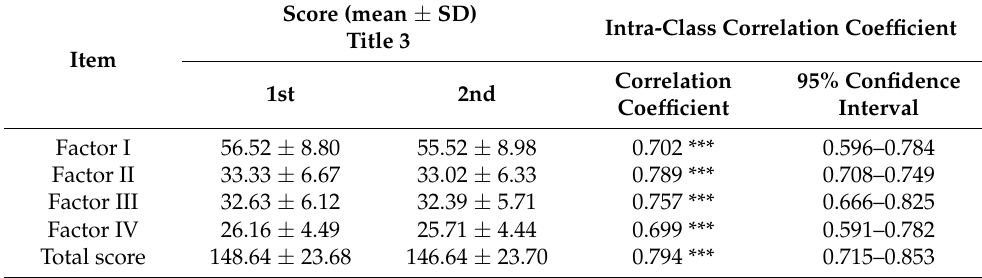
Table 2. Correlation of questionnaire scores by the test–retest method (N = 114).